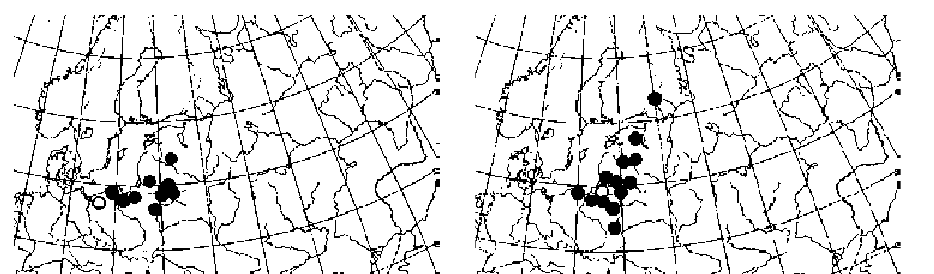
Fig. 1. Distribution of Verrucaria aquatilis in Eastern and East Central Europe (cid:2) records more than 50 year old, (cid:3) modern records